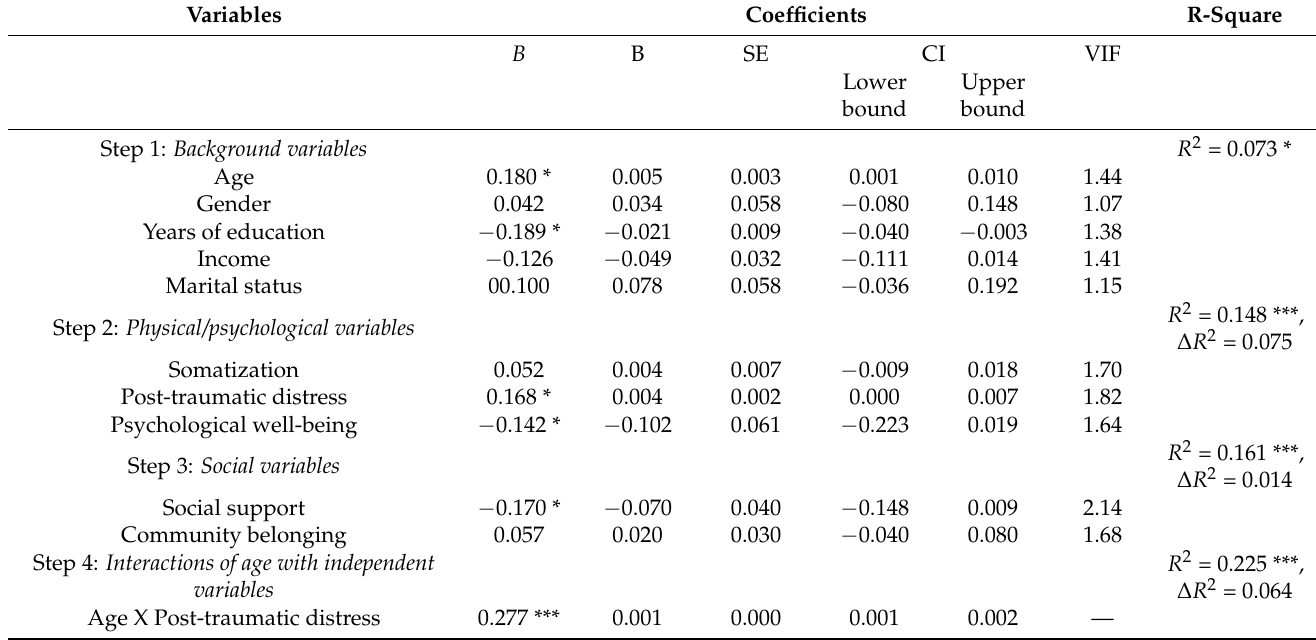
Table 2. Hierarchical regression coefficients for the variance in